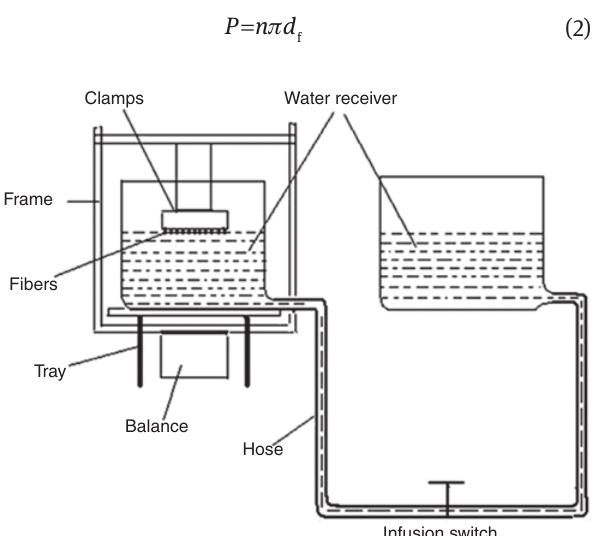
Figure 1: Schematic diagram of the improved wetting balance testing